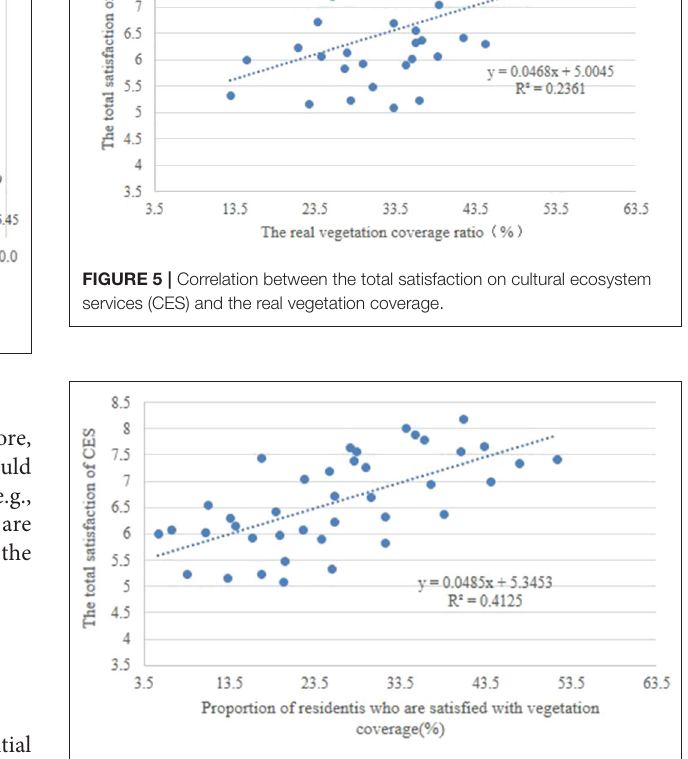
FIGURE 6 | Correlation between the total satisfaction on cultural ecosystem services (CES) and the proportion of residents who are satisfied with residential vegetation